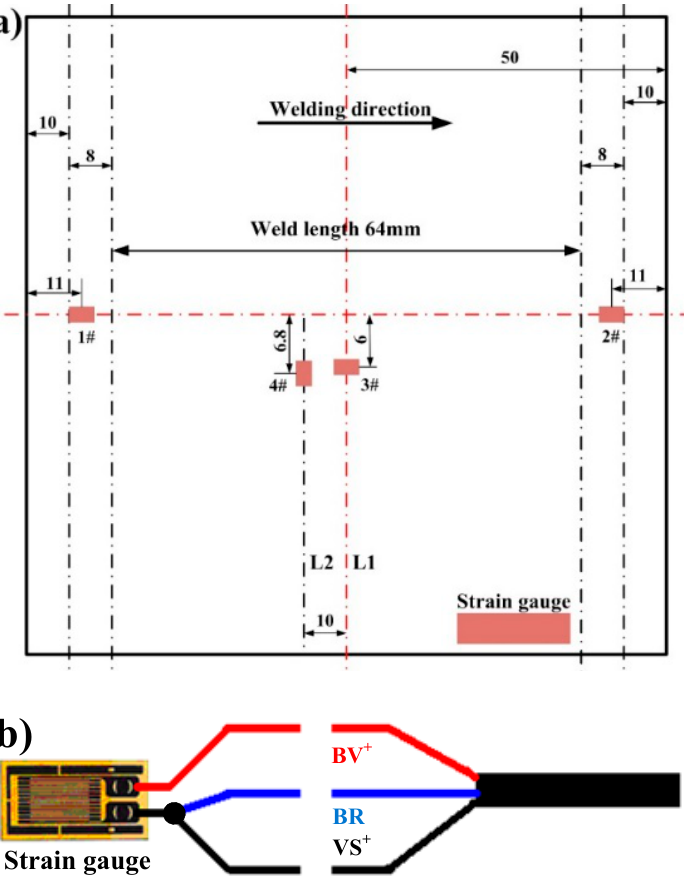
Figure 3. Measuring transient strain: ( a ) measurement points on the sample and ( b ) basic theory. Residual stress was detected by X-ray diffraction technology. Multiple Ψ method